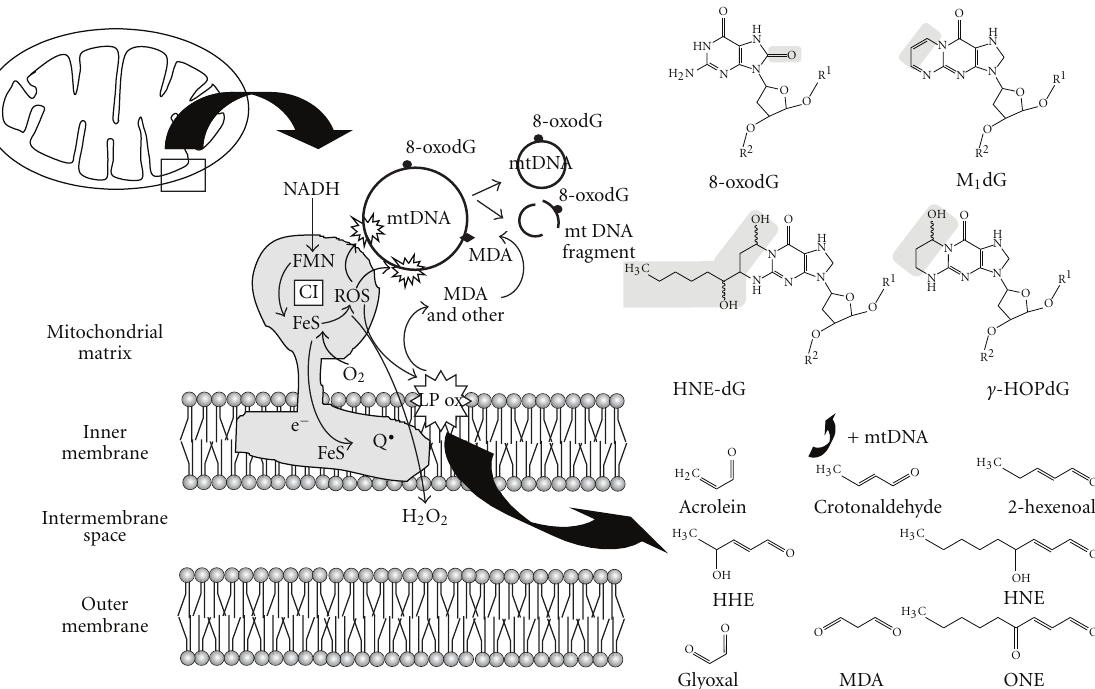
Figure 1: Schematic diagram of mitochondrial processes that are important for aging and longevity. The schematic shows that mitochondrial complex I is the main ROS generator. Several physiological mechanisms influencing the rate of mitochondrial ROS generation include: (i) the relative concentration of the respiratory complexes, (ii) the degree of electronic reduction of these generators, (iii) the uncoupling proteins, and (iv) specific chemical modifications. Oxygen radicals attack lipids, carbohydrates, proteins, and DNA. The products of lipid peroxidation include highly reactive molecules that can also cause lipoxidative damage to mitochondrial DNA. The scheme highlights two main characteristics of long-lived animal species likely contributing to their slow aging rate and superior longevity: highly resistant macromolecular components and low rate of generation of endogenous damage. Abbreviations: 8-oxodG, 8- oxo-7,8-dihydro-2 (cid:2) -deoxyguanosine; M1dG, Malondialdehyde-deoxyguanosine; HNE-dG, 4-hydroxy-2-nonenal-deoxyguanosine; HOPdG,